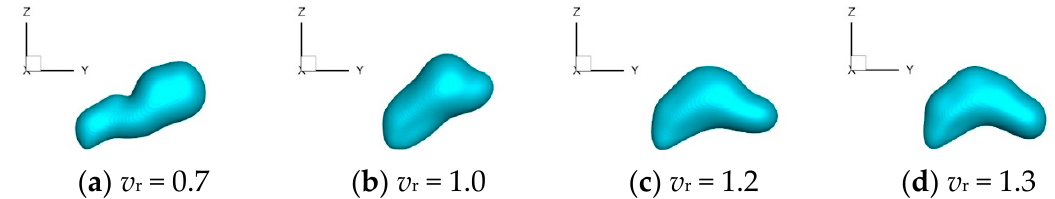
Figure 7. The di ff erent morphology of droplet rebounding from the surface with various velocity ratios at L z * = 1.18.